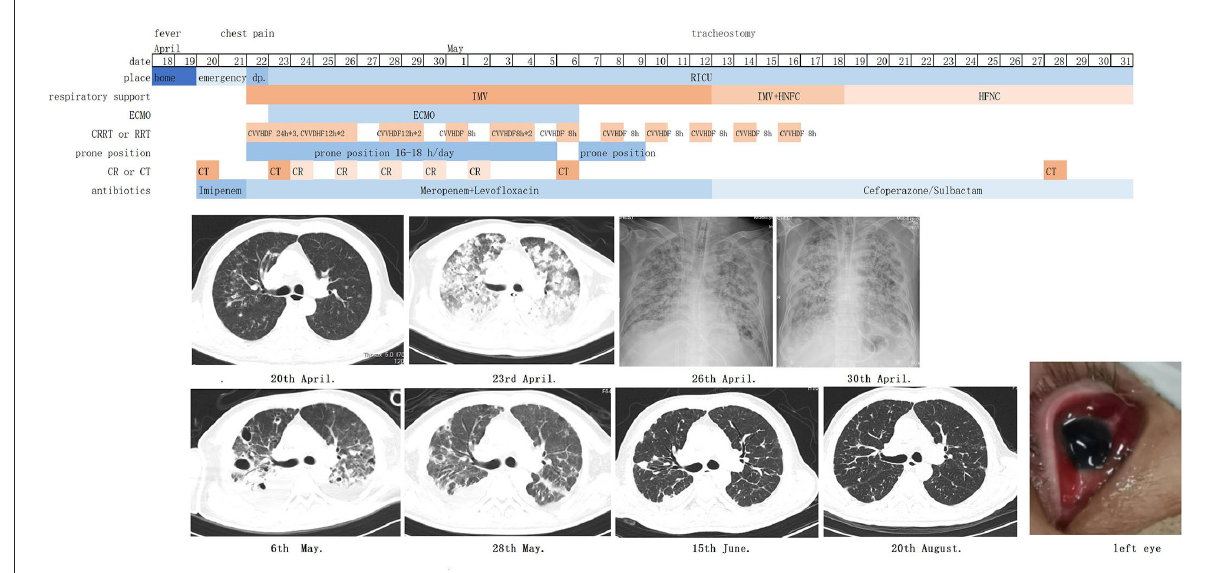
FIGURE1 Timeline of courses and treatments. IMV, invasive mechanical ventilation; HFNC, high-flow nasal cannula oxygen therapy; ECMO, extracorporeal membrane oxygenation; CRRT, continuous renal replacement therapy; CVVHDF, continuous venovenous hemodiafiltration; CT, computerized tomography; CR, Chest radiography.